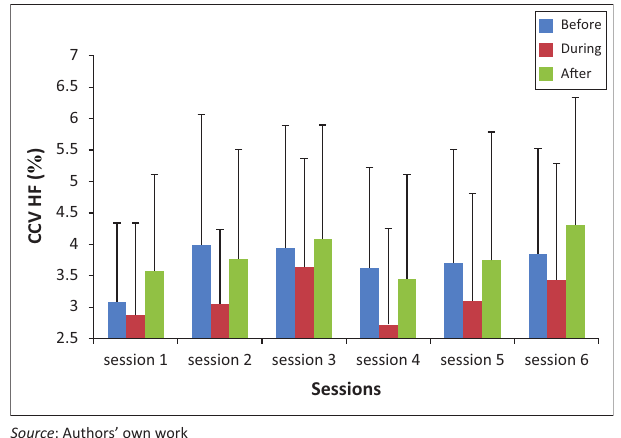
FIGURE 4: CCV for HF before, during and after therapeutic horseback riding (THR) over six sessions.